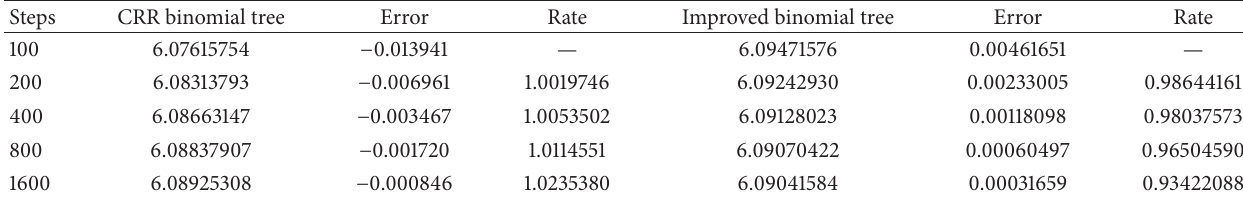
Table 3: Numerical results for Example